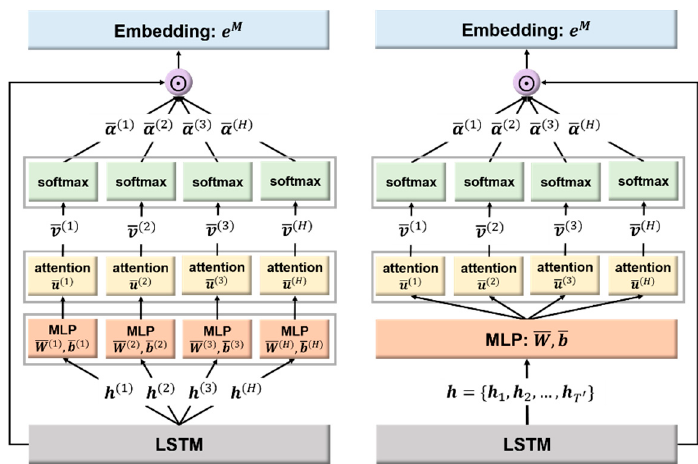
Figure 3. Block diagrams of speaker embedding extraction using multi-head attention with split ( left ) and multi-head attention with projection ( right ); α ( i ) , v ( i ) , and h denote attention weight, attention layer output, and LSTM output respectively.